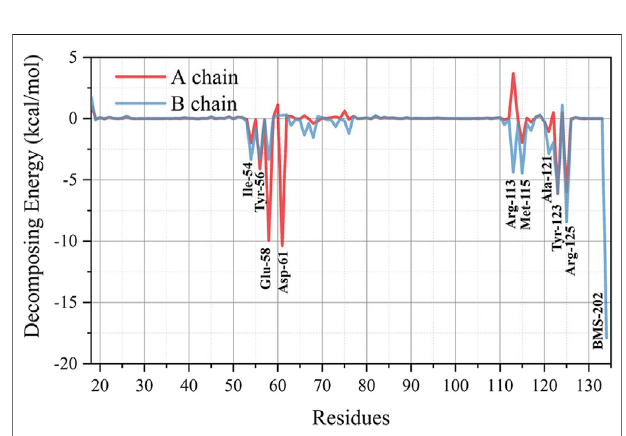
FIGURE 2 | The binding free energy decomposition result of every residue in the 5J89 system.